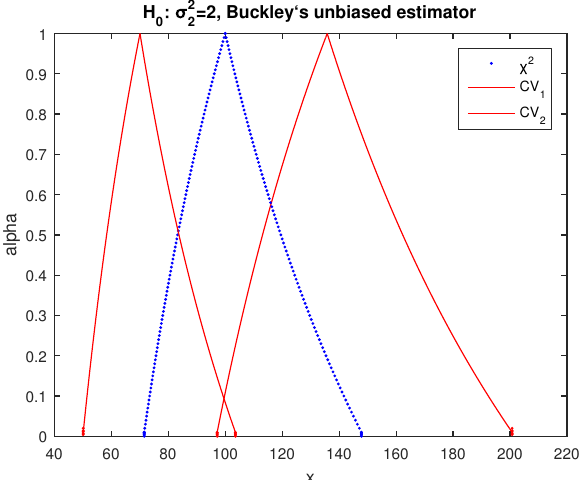
Figure 8. The possibility distribution of the fuzzy statistic (cid:102) χ 2 [ α ] for the test of H 0 of Example 3.